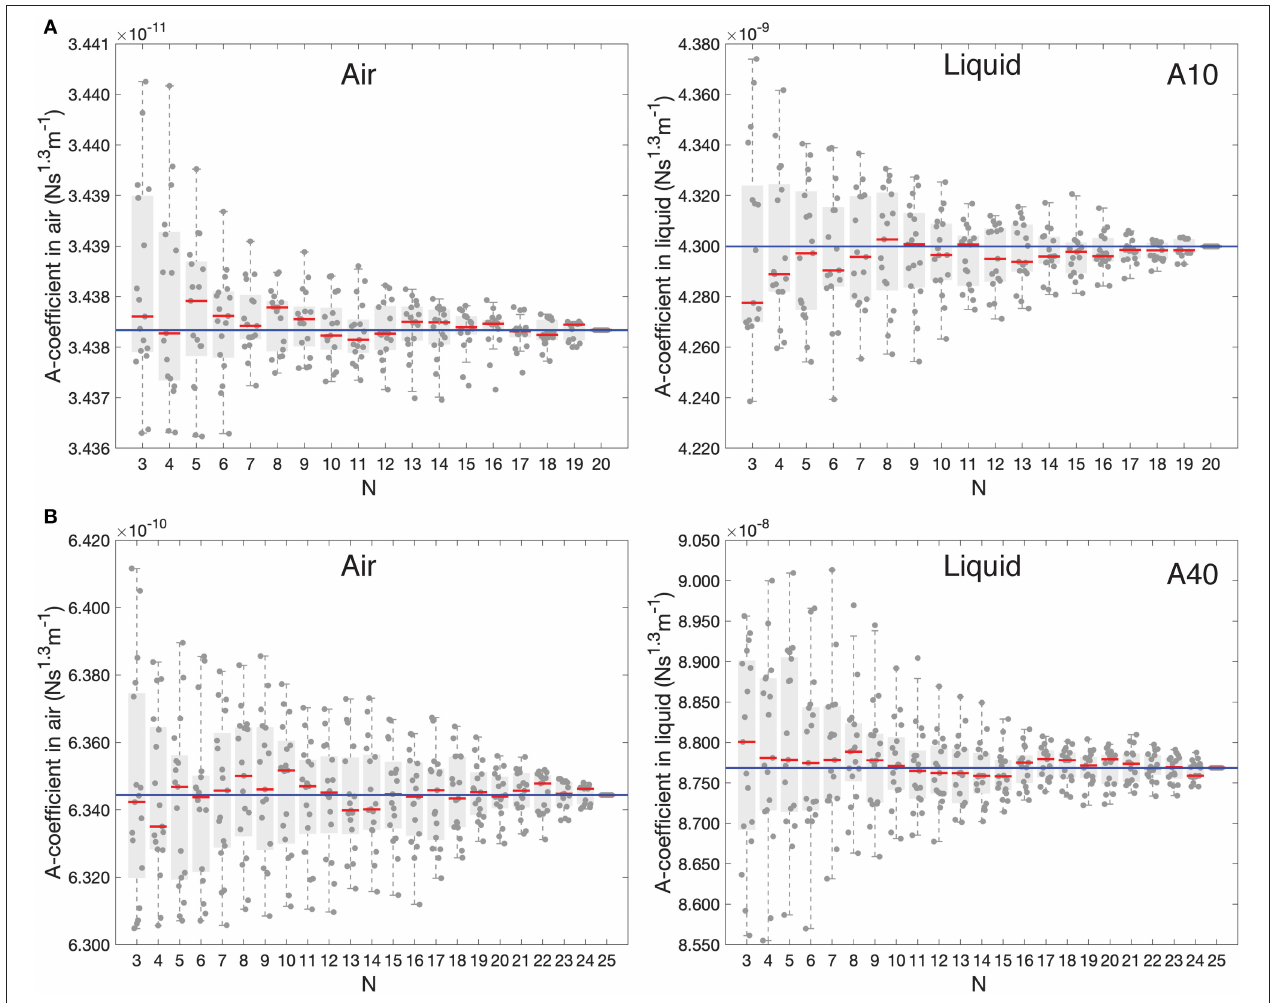
FIGURE 3 | Boxplots showing the 17 repetitions (symbols) of the average A -coefficient calculated using N random reference cantilevers from our pool. The Red line is the median, boxes show the 25th and 75th percentiles, and whiskers represent the most extreme values not considered as outliers. The blue solid line is the average A -coefficient with all N considered. (A) AC10 cantilevers (B) AC40